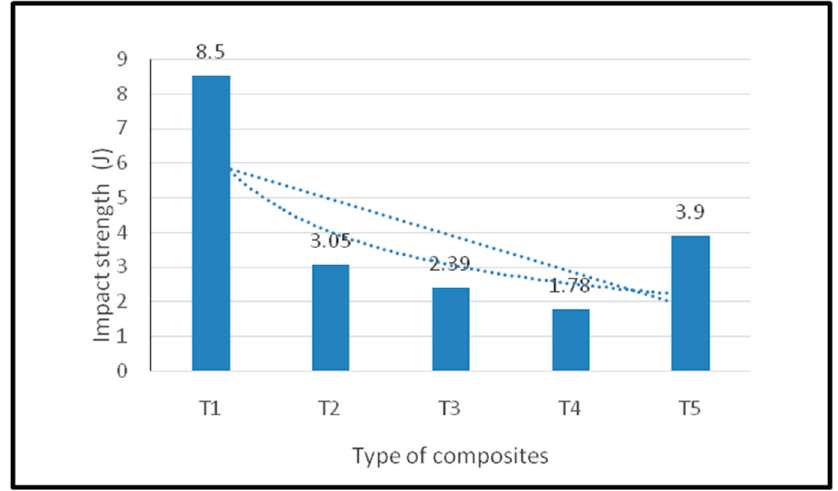
Figure 4. Impact strength of oil palm EFB/woven kenaf fiber-reinforced epoxy-based bi-layer Figure4. ImpactstrengthofoilpalmEFB / wovenkenaffiber-reinforcedepoxy-basedbi-layercomposites. composites.